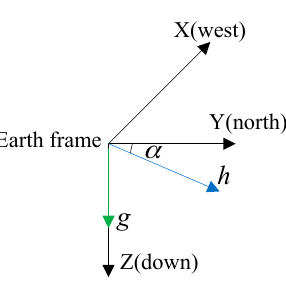
Figure 3. The geomagnetic field in the Earth frame. g is the gravity acceleration. h is the geomagnetic field. The length of h represents the magnitude. The angle α between the horizontal and magnetic field is defined as the dip angle.